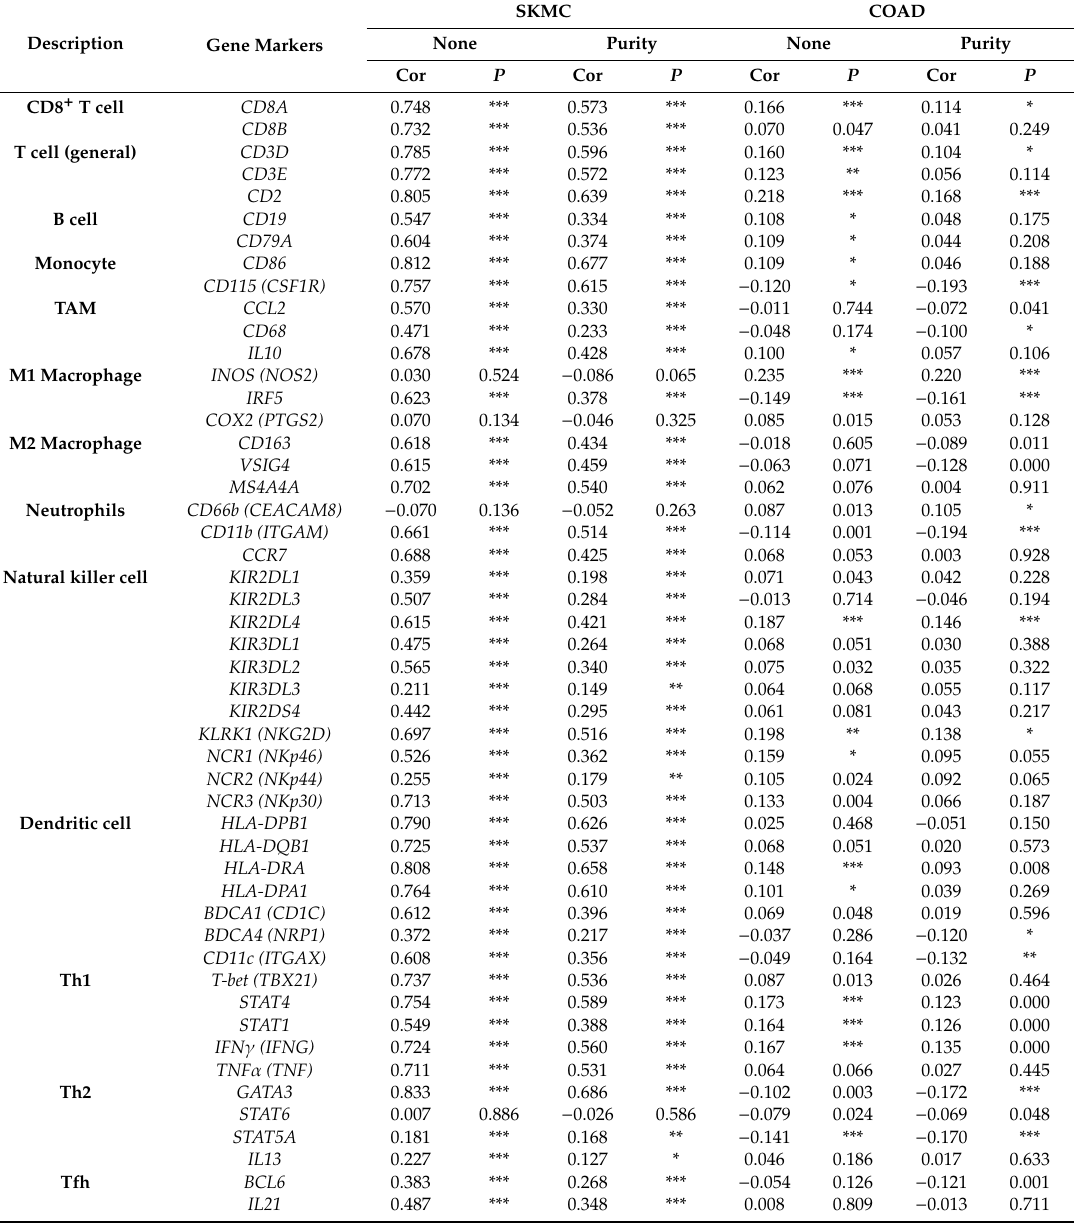
Table 1. Correlation between IL18 and markers of various immune cells in the Tumor Immune Estimation Resource